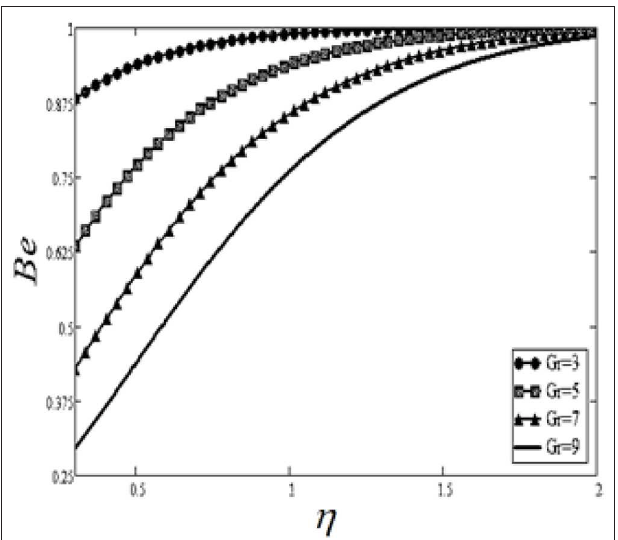
FIGURE 12 | Bejan number plot for Gr .